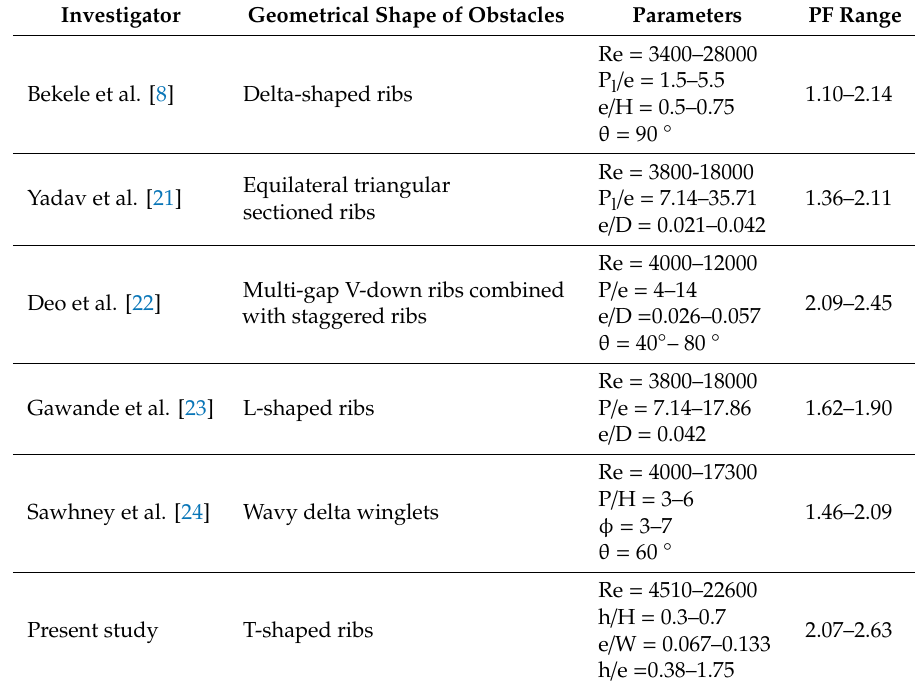
Table 3. Comparison of performance factor range obtained in the present study with those obtained in the previous experimental or numerical studies on obstacle shape.